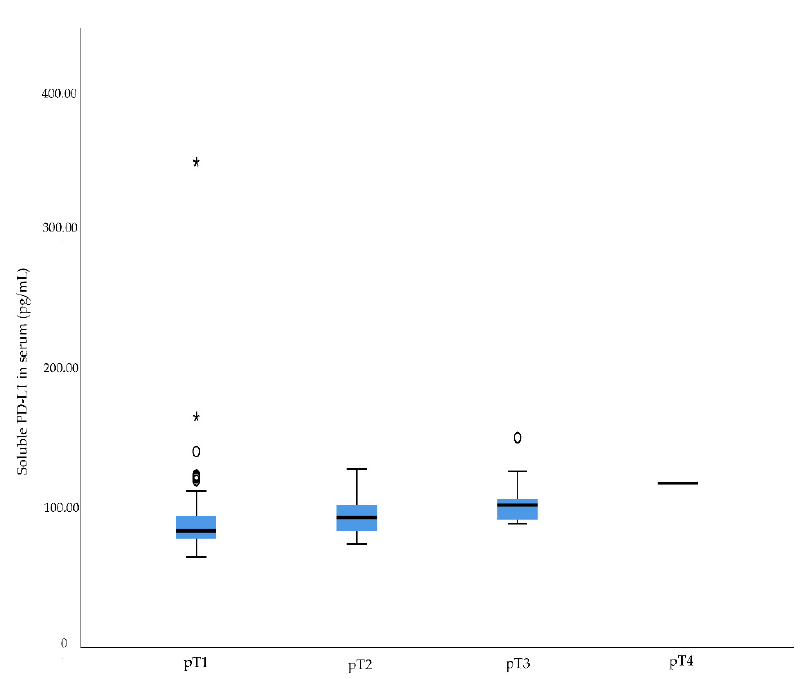
Figure 2. Soluble programmed death ligand 1 (sPD-L1) serum levels in renal cell carcinoma patients with different pT stages. Higher sPD-L1 level was associated with higher pT stage, p = 0.001. Outliers in the data are represented by a circle ( ◦ ), and extreme outliers are represented by an asterisk